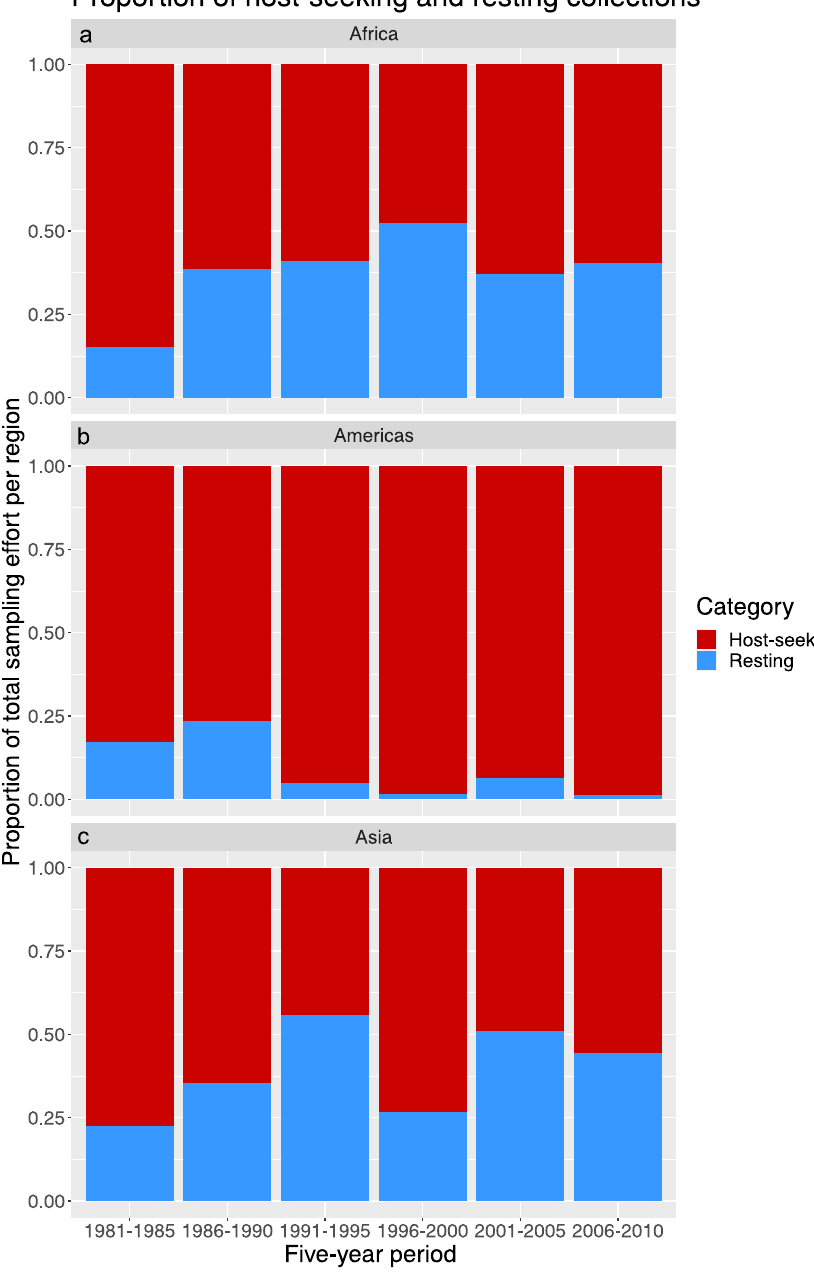
Figure 3. Proportion of host-seeking and resting collections. The proportion of host-seeking (red) and resting (blue) collections presented per 5 year time period for each region analysed. ( a ) Africa, ( b ) Americas, ( c ) Asia- Pacific